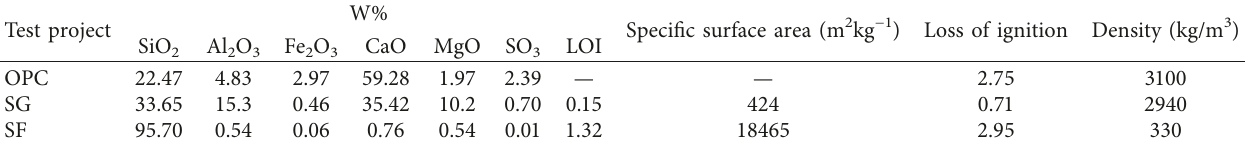
Table 2: Chemical composition of cementitious